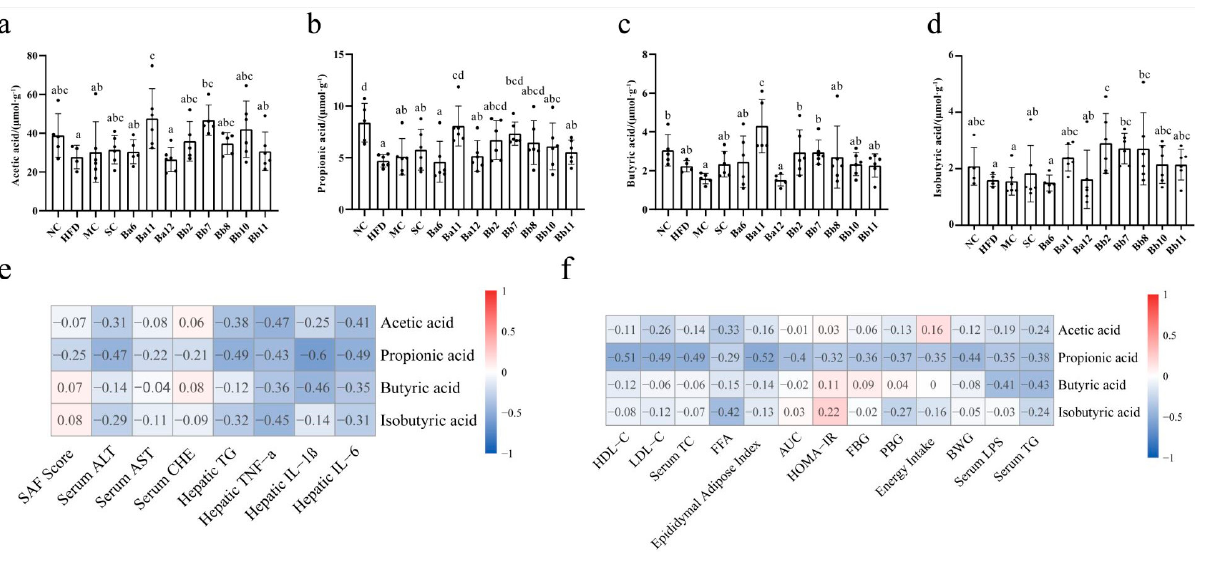
Figure 5. Effects of Bifidobacterium on SCFAs in NAFLD mice. ( a ), acetic acid; ( b ), propionic acid; ( c ), isobutyric acid; ( d ), butyric acid; ( e ), the correlation analysis of SCFAs and hepatic damage; ( f ), the correlation analysis of SCFAs and alleviation pathways. Mean values with different letters (a–d) over the bars are significantly different ( p < 0.05) according to Duncan’s multiple range test. Cell